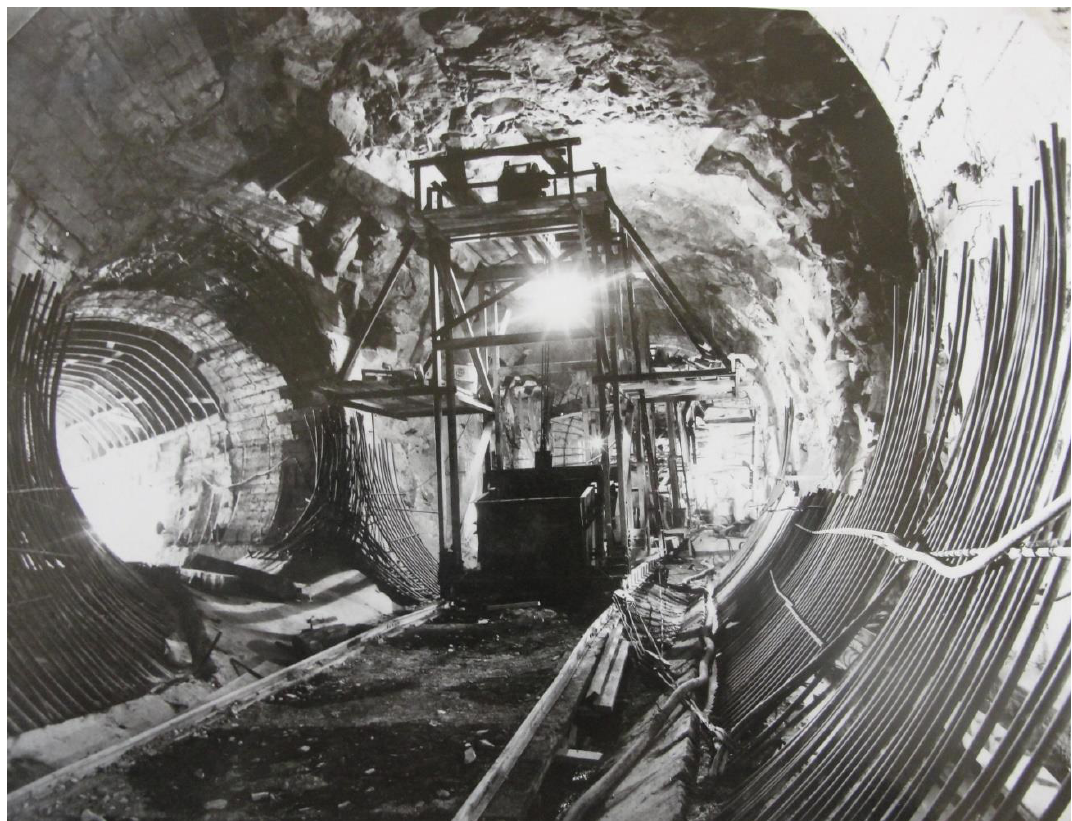
Figure 2. Construction of the power tunnels of Hirfanlı Dam—Turkey [3].